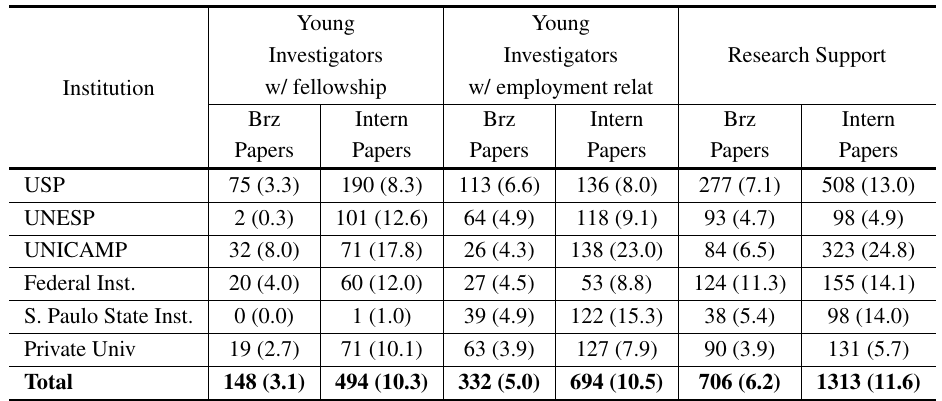
Papers published during the YI and RS projects and after their